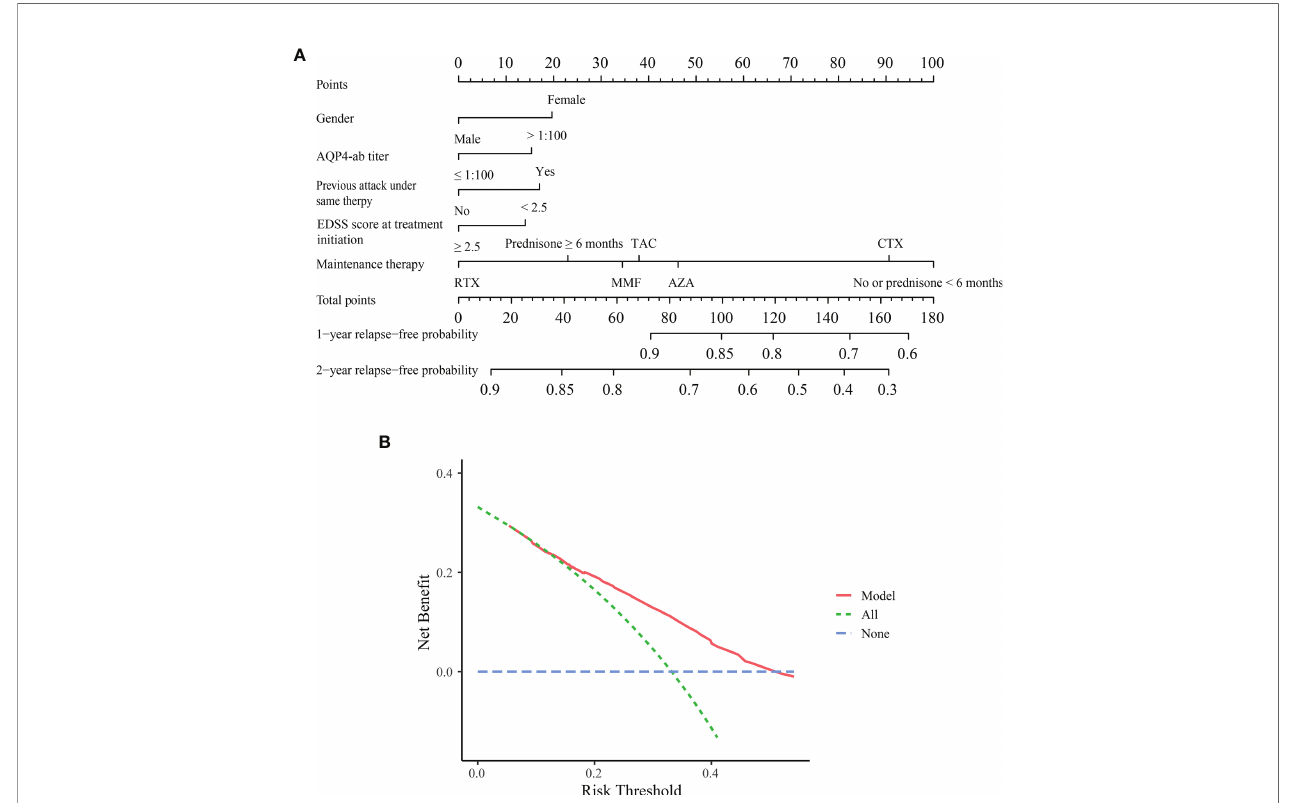
FIGURE 2 | Nomogram and decision curve analysis in the primary cohort. (A) Nomogram for predicting 1- and 2-year relapse-free probability in the primary cohort. Based on each variable axis of the nomogram, the probability for each patient was determined (upward-pointing line). At the total-points axis, the sum of points corresponds to 1- and 2-year relapse-free probability (downward-pointing line). (B) Decision curve analysis for the Model. The decision curve revealed that if the threshold probability exceeds 0.15, this nomogram was superior for predicting subsequent relapses compared to either treat-all or treat-none scheme. ON, optic neuritis; TM, transverse myelitis; EDSS, Expanded Disability Status Scale; AZA, azathioprine; MMF, mycophenolate mofetil; TAC, tacrolimus; RTX, rituximab; CTX, cyclophosphamide.